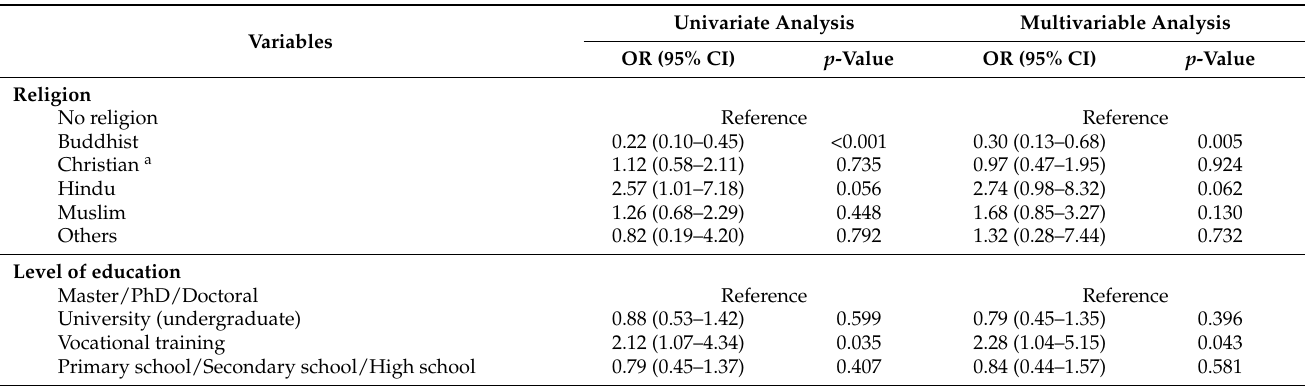
Table 2. Multivariable regression